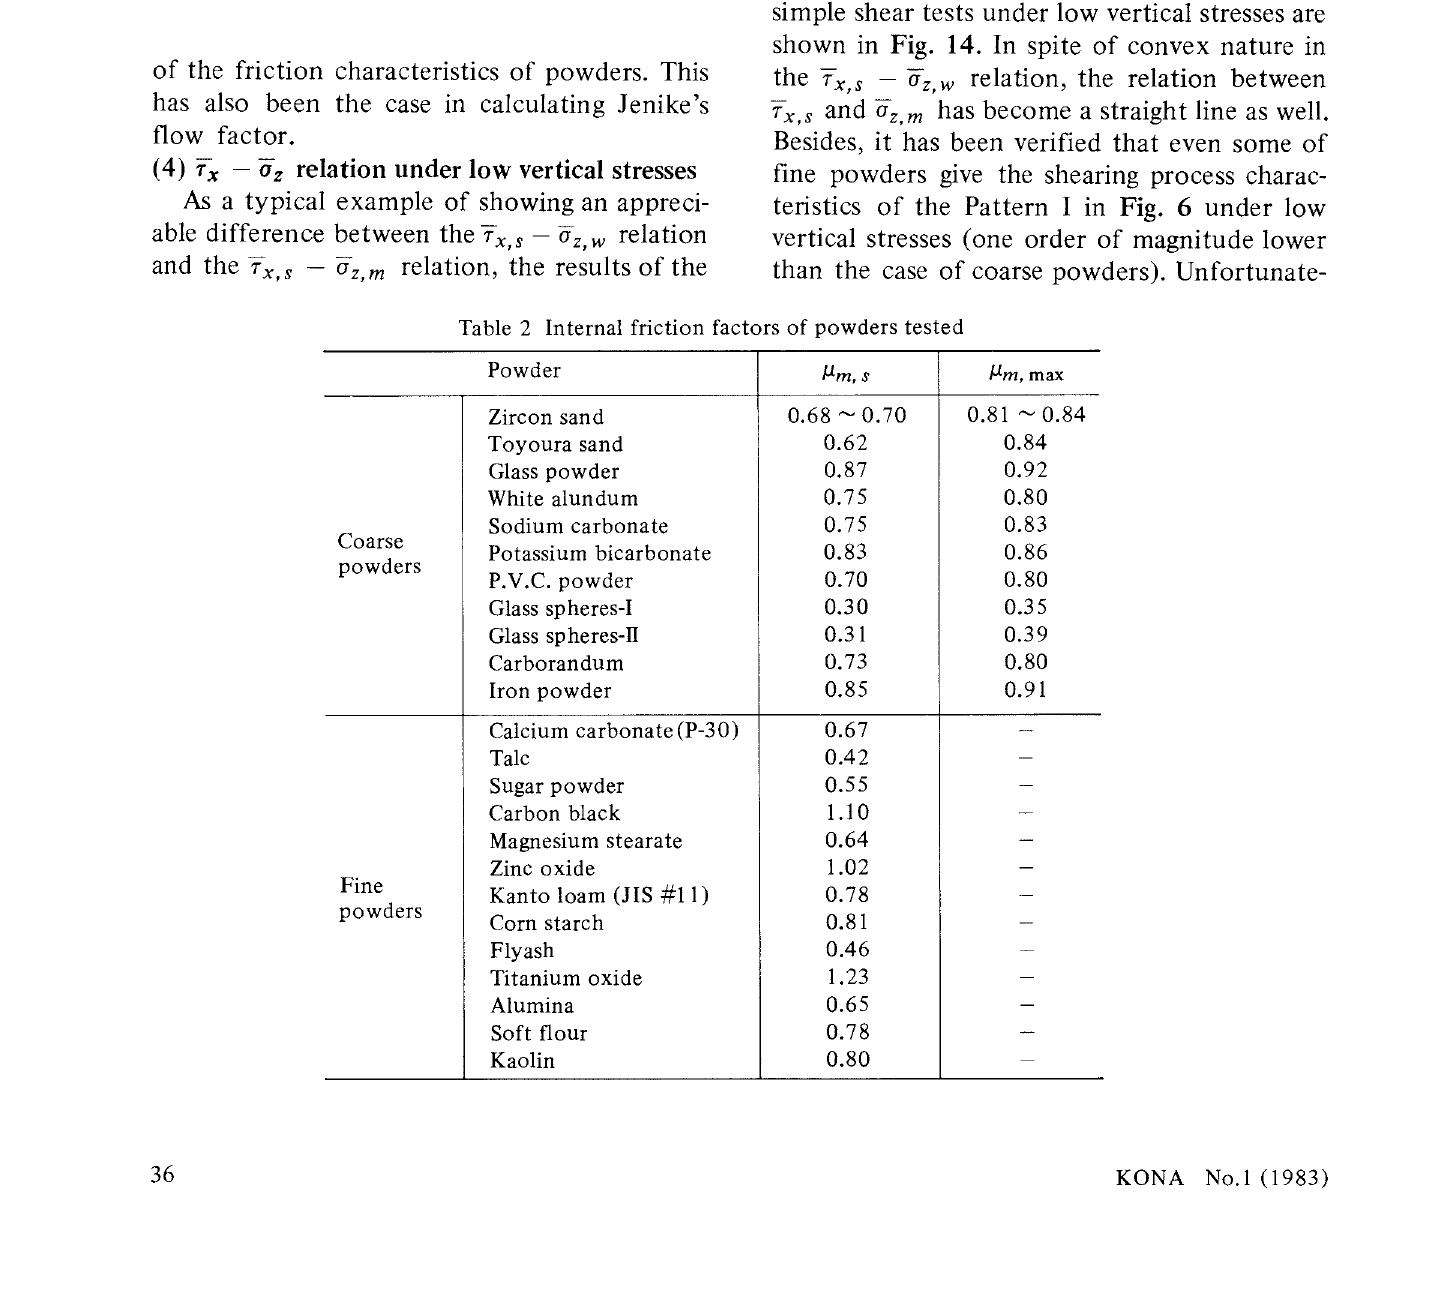
Fig. 13 Effect of initial void fraction € 0 on the yield locus of a fine powder in terms of Tx,s - Oz, w and Tx,s- Oz,m Fig. 12 Effect of initial void fraction € on the yield 0 locus of a fine powder in terms of Tx,s - Oz, w